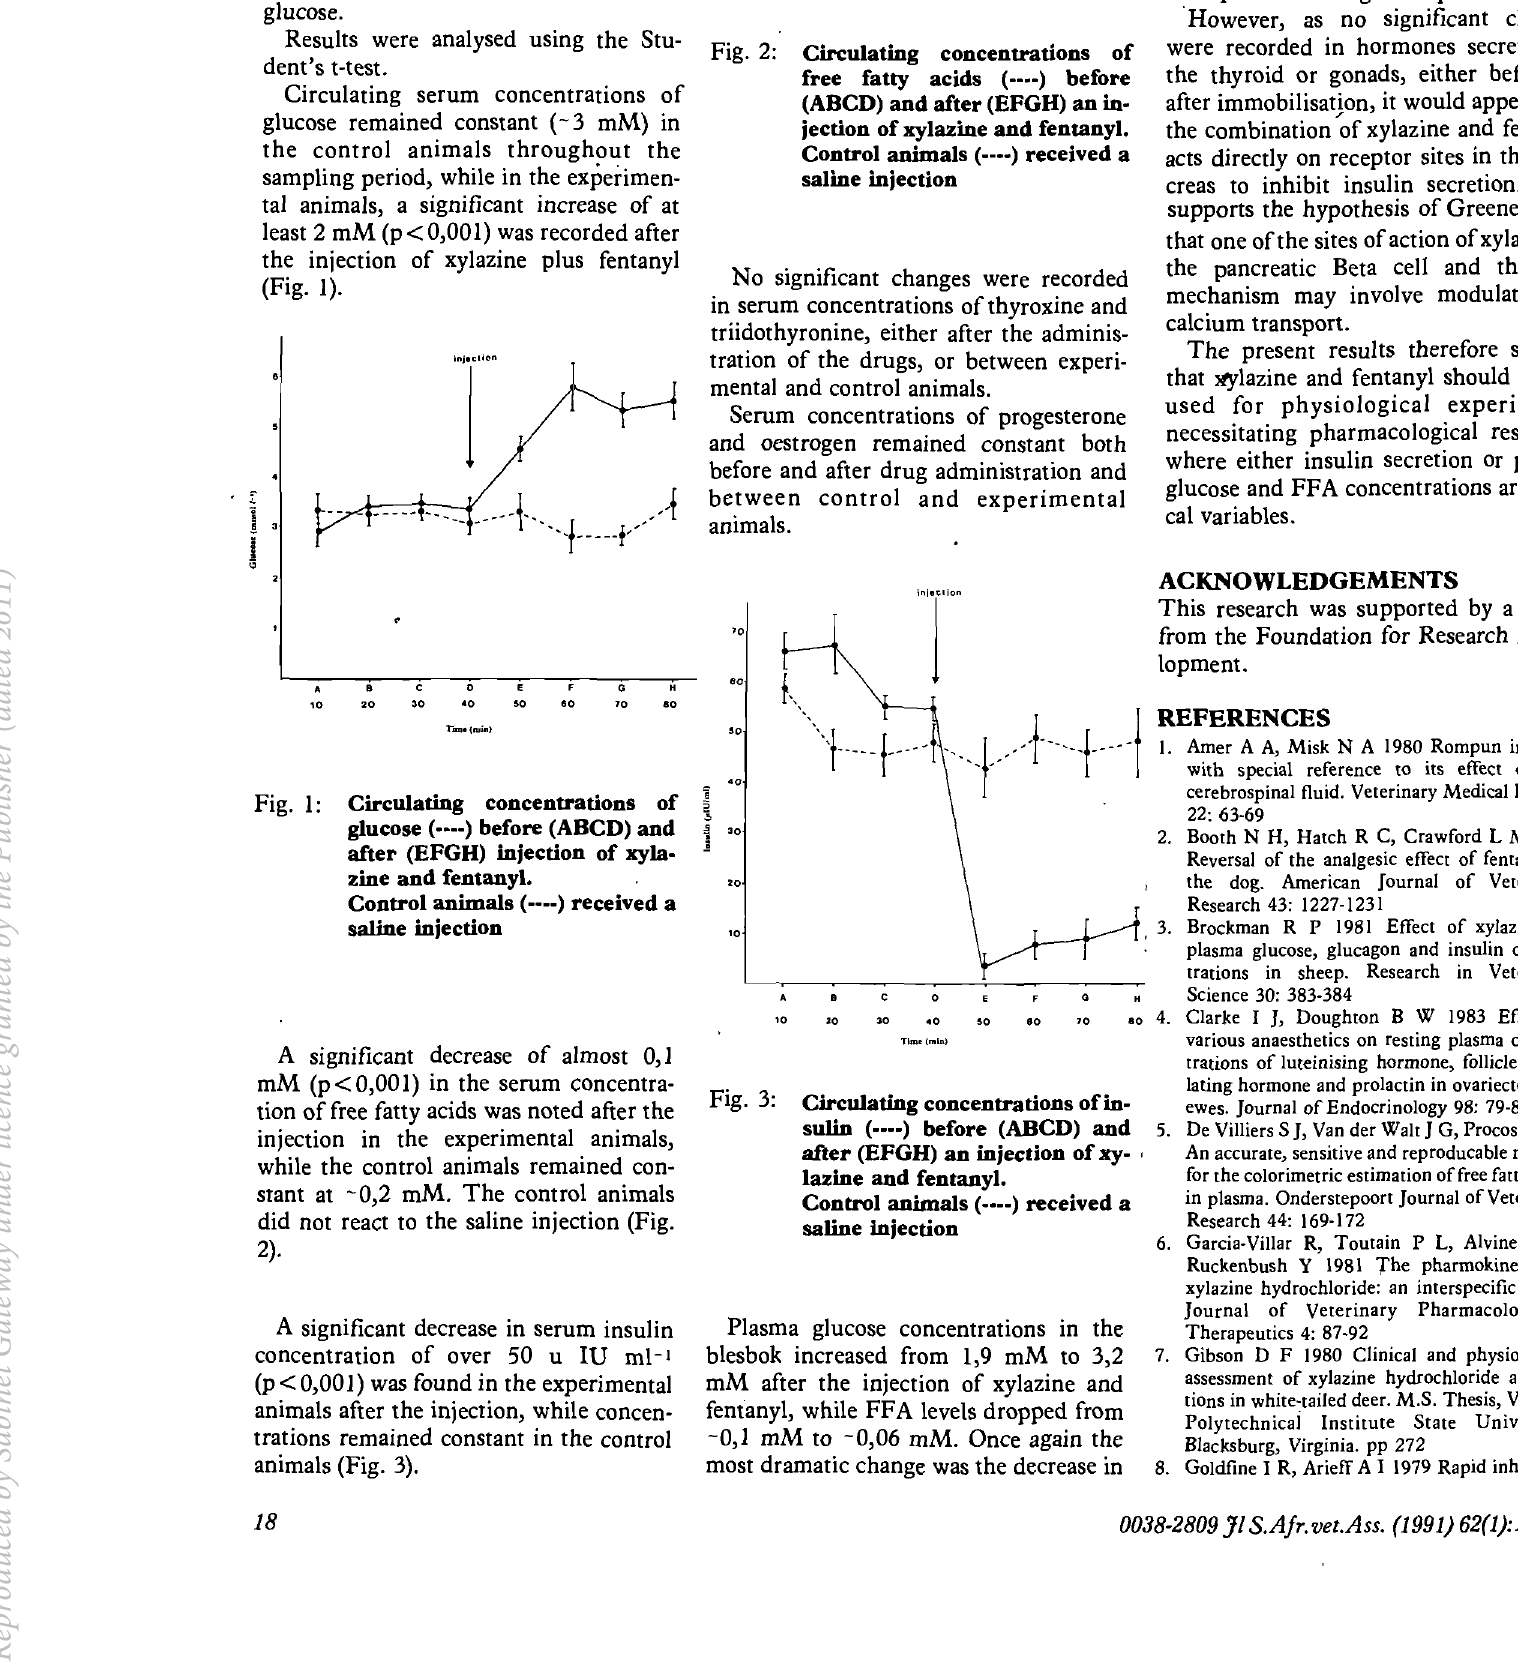
Plasma glucose concentrations in the blesbok increased from 1,9 mM to 3,2 mM after the injection of xylazine and fentanyl, while FF A levels dropped from -0,1 mM to -0,06 mM. Once again